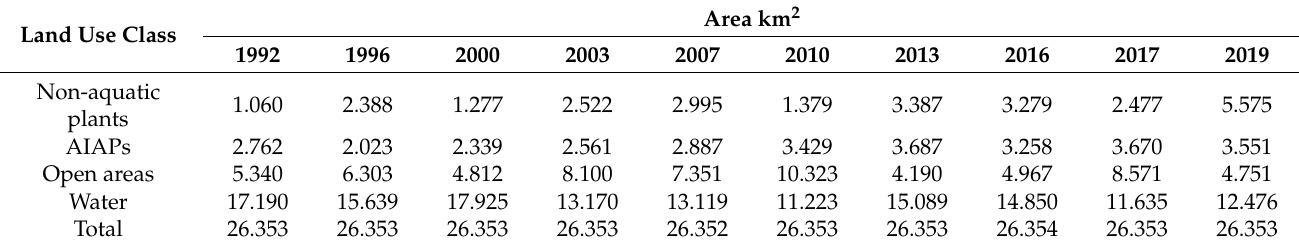
Table 4. Representation of areas of four land use classes of the classified images from 1992 to